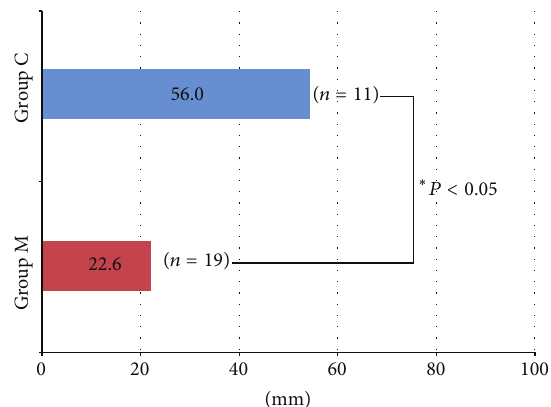
Figure 7: Pain caused by orthodontic treatment (visual analogue scale method).